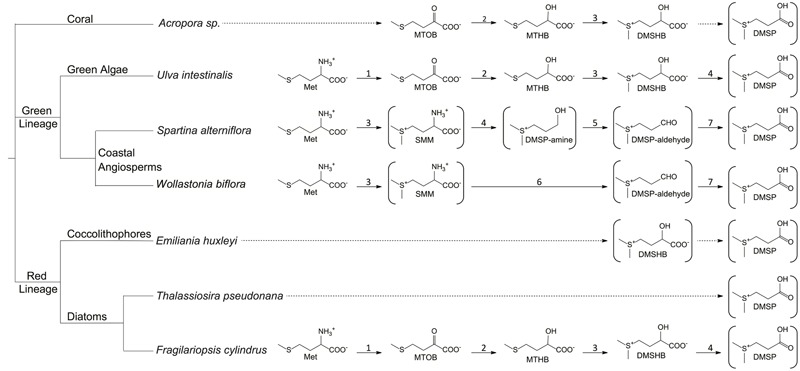
Proposed DMSP biosynthetic pathways. Structures in brackets have been detected and verified. Complete arrows signify reactions that are identified or predicted based on the observed intermediates. Dotted arrows signify unknown reactions. 1, aminotransferase; 2, NADPH-reductase; 3, methyltransferase; 4, decarboxylase; 5, oxidase; 6, decarboxylase/transaminase; 7, dehydrogenase. MTOB, 4-methylthio-2-oxobutyrate; MTHB, 4-methylthio-2-hydroxybutyrate; DMSHB, 4-dimethylsulfonio-2-hydroxybutyrate; SMM, S-methyl-L-methionine. (Hanson et al., 1994; James et al., 1995; Kocsis et al., 1998; Summers et al., 1998; Kocsis and Hanson, 2000; Lyon et al., 2011; Raina et al., 2013).